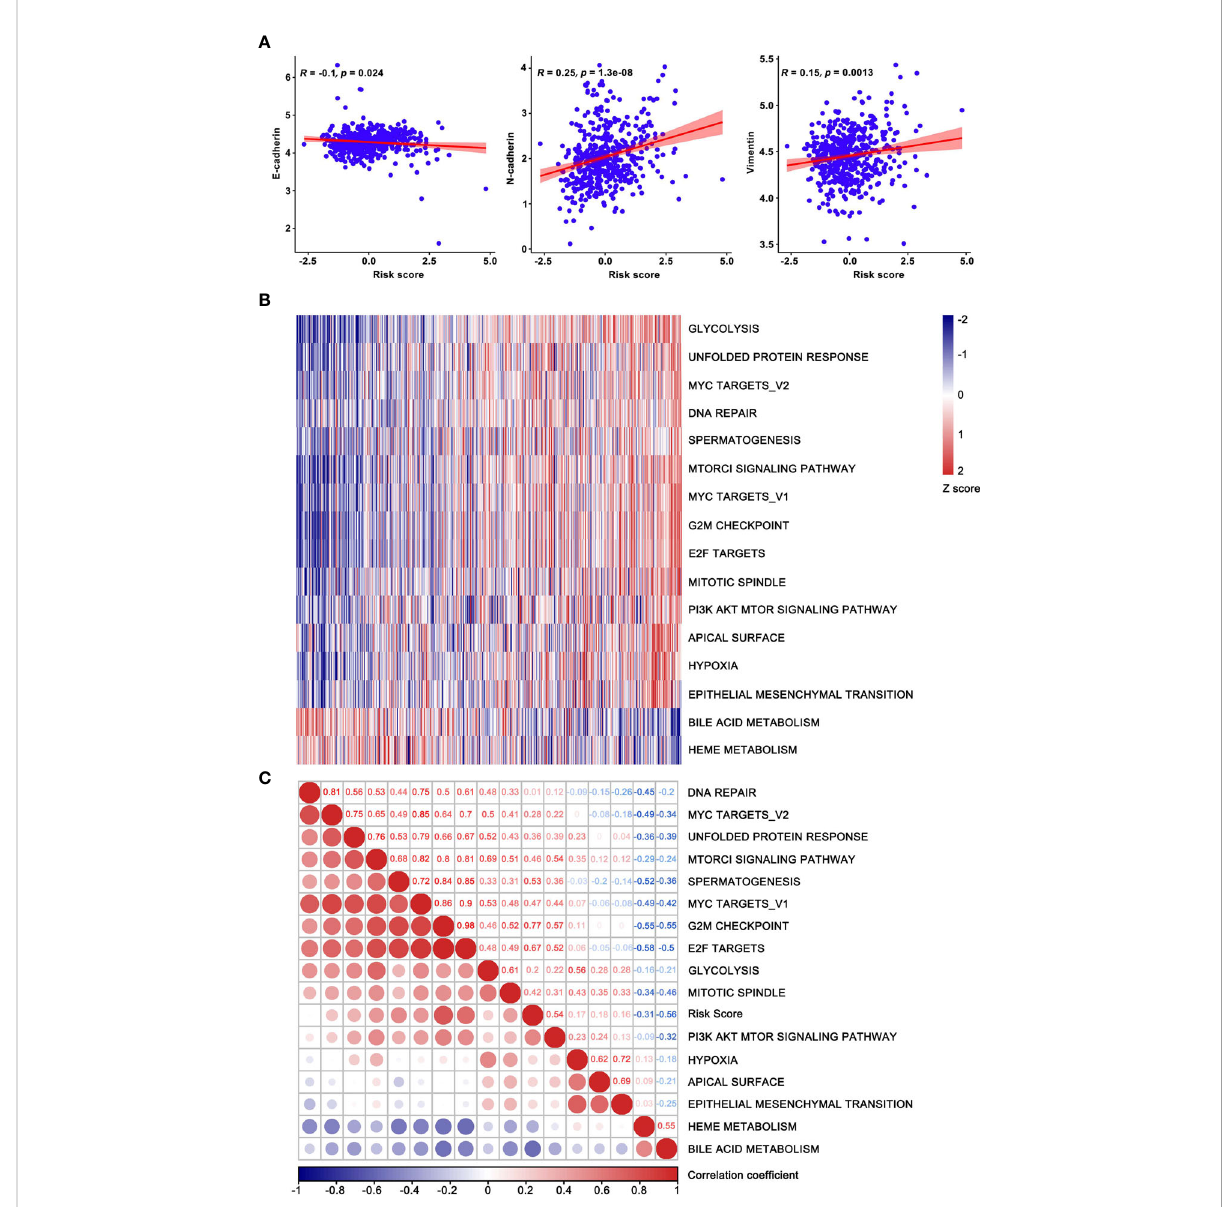
FIGURE 7 Functional enrichment analysis based on the current prognostic model. (A) The correlation between risk score and EMT biomarkers. (B) Hierarchical clustering analysis was used for heatmap plotting, showing KEGG pathways correlated with the model and coef fi cients were greater than 0.3. (C) The correlation map con fi rmed the high-risk group retained the oncogenic pathways. The risk score increased successively from left to right, where the enriched pathways and risk score were used as the